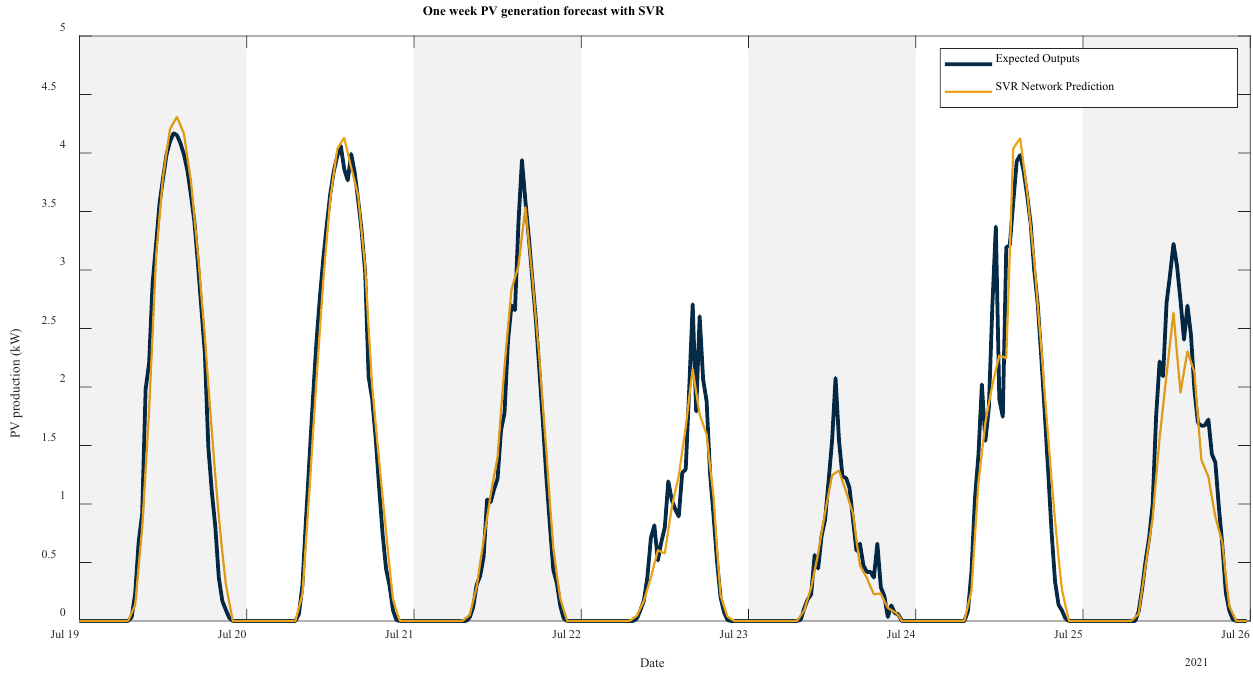
Figure 13. Forecast of PV generation for a week of July with SVR model. Afterward, continuing with the analysis of the behavior of the models according to the type of day, Table 7 shows the R 2 values for five sunny days and five cloudy days. It is clearly noticeable that on sunny days the R 2 is around 0.95, whereas when the day is cloudy, regardless of the model, the R 2 values are around 0.8. In this case, also, the SVR model stands out for obtaining the best